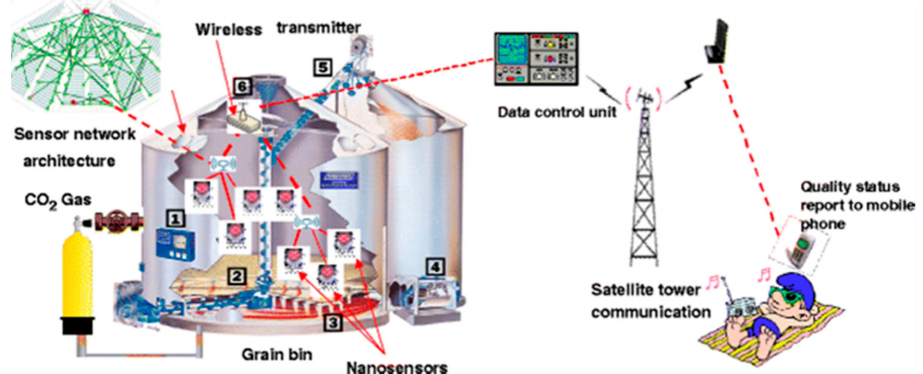
Figure 4. Futuristic nanosensor based on wireless network for grain-spoilage detection. ( 1 ) Control panel, ( 2 ) grain auger, ( 3 ) air plenum, ( 4 ) fan, ( 5 ) auger to transfer grain, if needed, ( 6 ) wireless transmitter (reproduced with permission from Reference [1]).